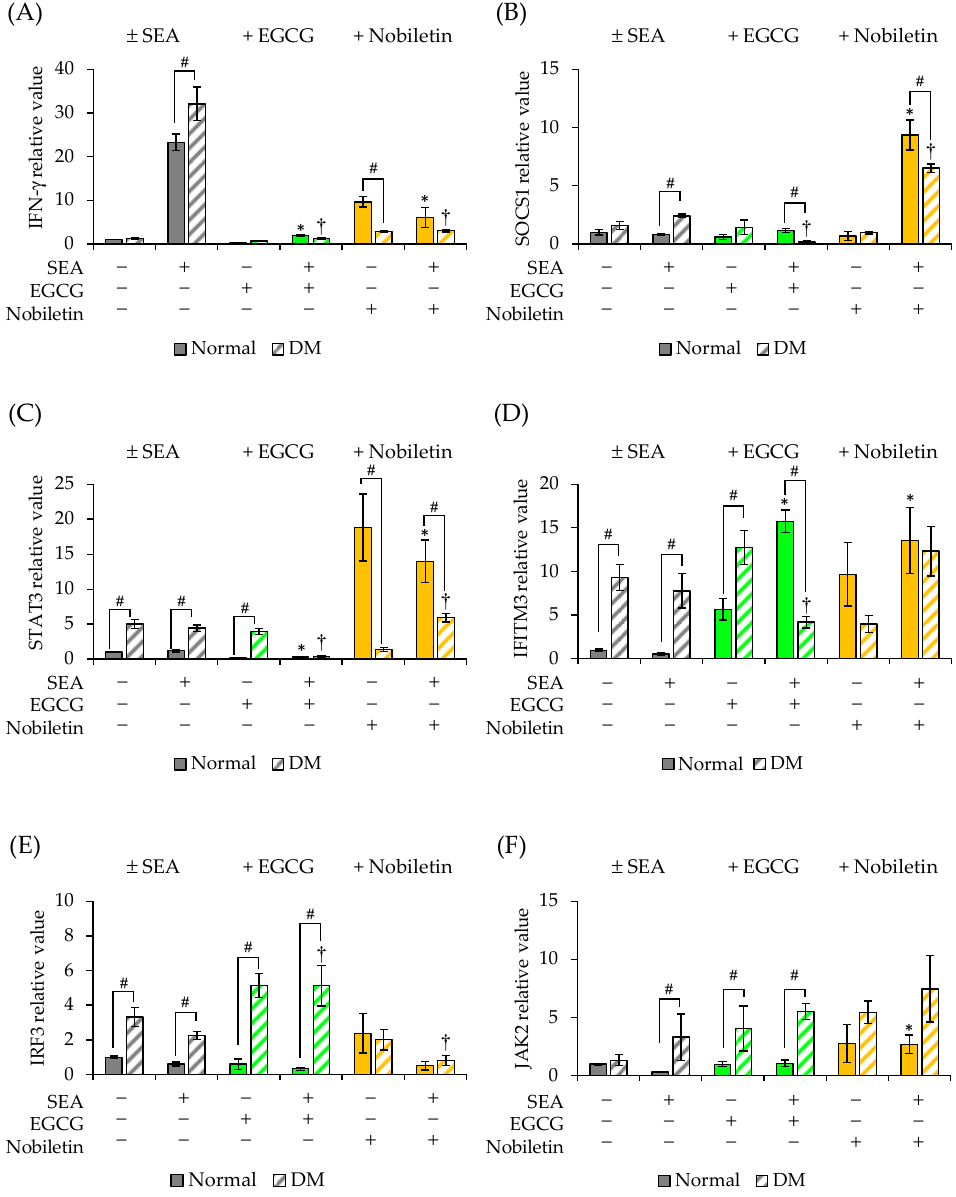
Figure 6. The effect of polyphenols on the SEA-induced expression of JAK/STAT pathway-related genes in spleen cells from normal mice and diabetic mice (DM). ( A ) IFN- γ , ( B ) SOCS1, ( C ) STAT3, ( D ) IFITM3, ( E ) IRF3, ( F ) JAK2. Spleen cells from normal mice (control) and DM were exposed to different combinations of SEA (50 ng/mL), EGCG (0.05 mM), and nobiletin (0.05 mM), and the expression of JAK/STAT pathway-related genes was examined by real-time RT-PCR. Gene expression was normalized to that of the Hprt gene. The fold change was determined relative to the control without SEA. * p < 0.05 compared to normal—SEA, † p < 0.05 compared to DM—SEA, # p < 0.05 compared to normal. The values represent the mean ± standard deviation of three independent